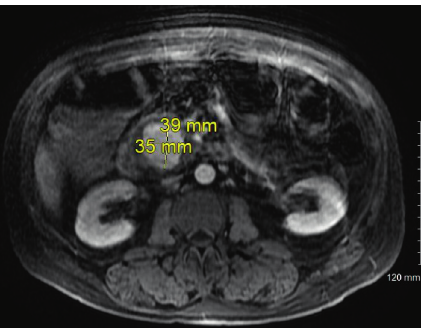
Figure 3: Magnetic resonance imaging with measurement of